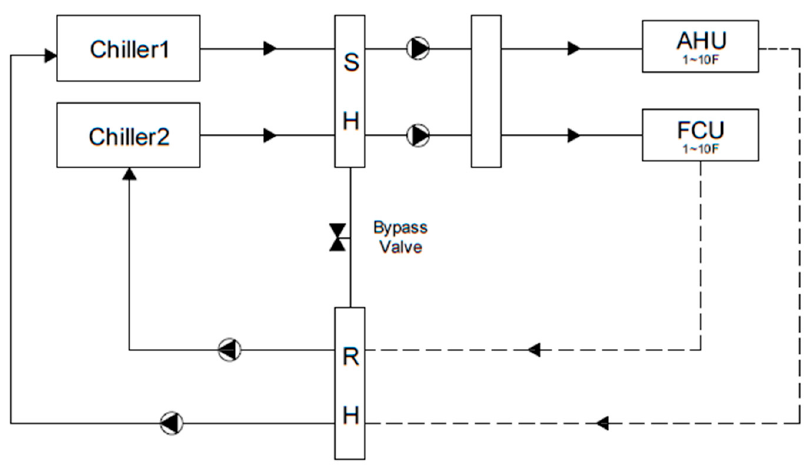
Figure 4. Heat source system diagram for the target office.